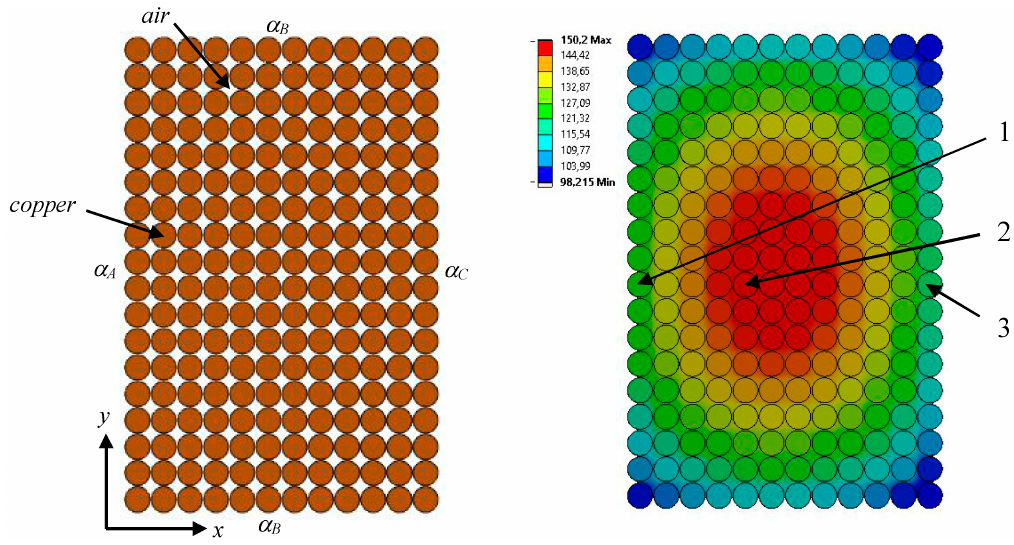
Figure 7. Model boundary condition settings ( left ); temperature distribution in the coil cross-section ( right ). ( right